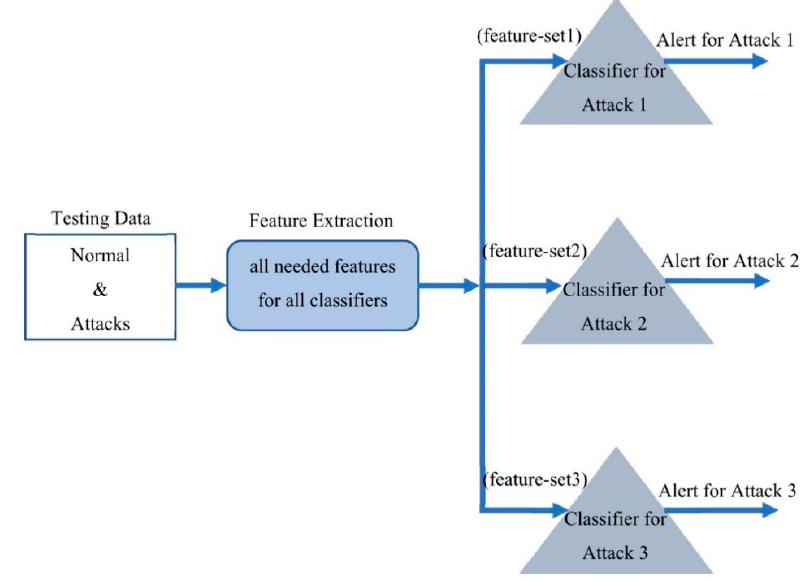
Figure 3. The testing phase (the case of three classifiers).